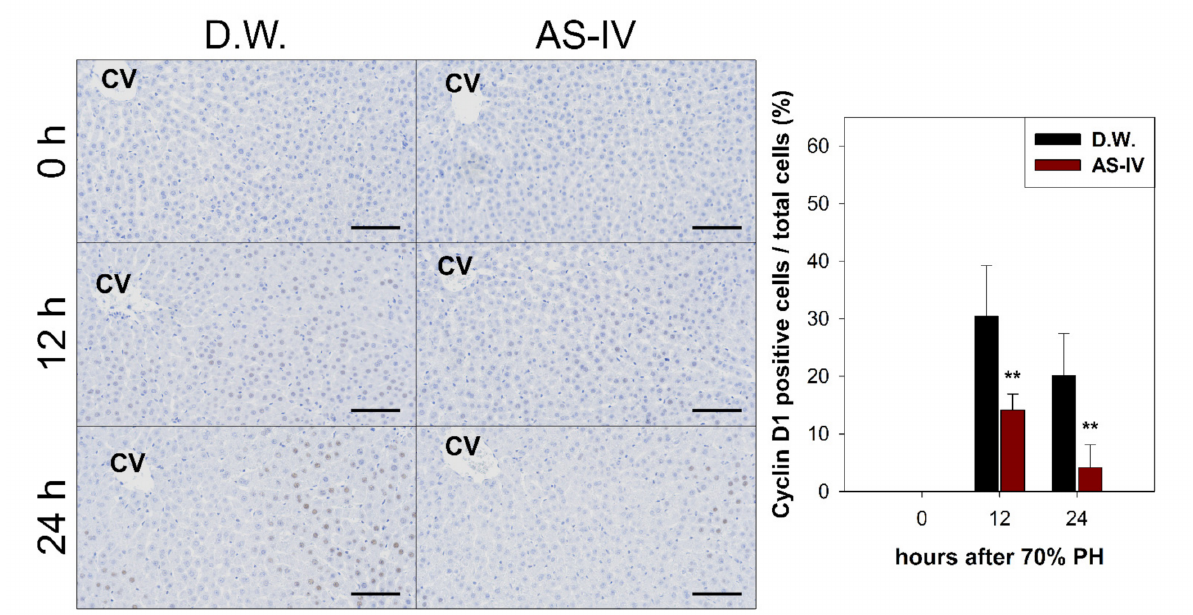
Figure 5. Immunostaining for cyclin D1. Cyclin D1 expression in regenerating liver tissues rapidly increased 12 h after PHx, peaking at 12 h after PHx then decreasing by 24 h. The AS-IV group showed a low expression of cyclin D1. Hematoxylin was used as a counter stain. (Scale bar indicates 100 µ m, CV: central vein, n = 3, mean ± standard deviation, **: p <